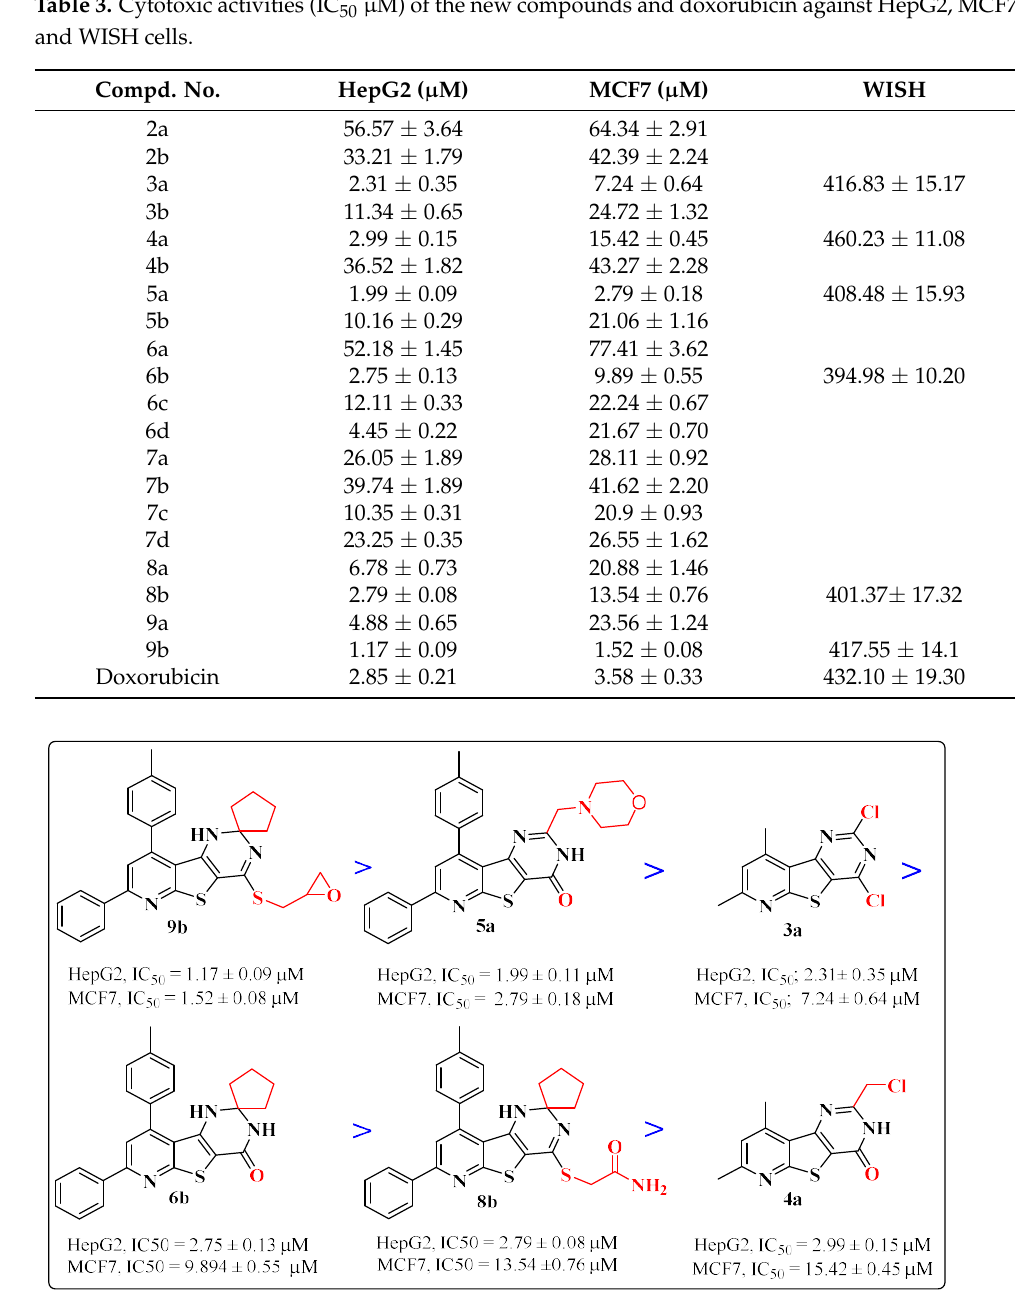
Figure 4. The cytotoxic activity of the most potent compounds. Additionally, the spiro cyclopentane sulfanylacetamide 8b produced an equivalent cytotoxic potency to that obtained by doxorubicin against HepG2 cells, with an IC 50 value of 2.79 µM, but less potency than doxorubicin against MCF7, with an IC 50 value of 13.54 µM. The spiro cyclohexane sulfanylacetamide analogue 8a appeared to be a less potent growth inhibitor towards both HepG2 and MCF-7 cancer cells, with IC 50 values of 6.78 and 20.88 µM, respectively. Finally, the 2-chloromethyl-7,9-dimethyl derivative 4a , the last among the most potent compounds, showed significant growth inhibitory activity against HepG2 cancer cells with IC 50 = 2.99 µM, but its potency decreased against MCF-7 cells with an IC 50 value of 15.42 µM, whereas a high drop in activity was shown by the 7- phenyl-9-p-tolyl analogue 4b towards the two cancer cell lines with IC 50 values of 36.52 and 43.27 µM, respectively. The rest of the target compounds, the spiro[cycloalkane-1,2′- pyridothienopyrimidine-4′(3′ H )-thiones